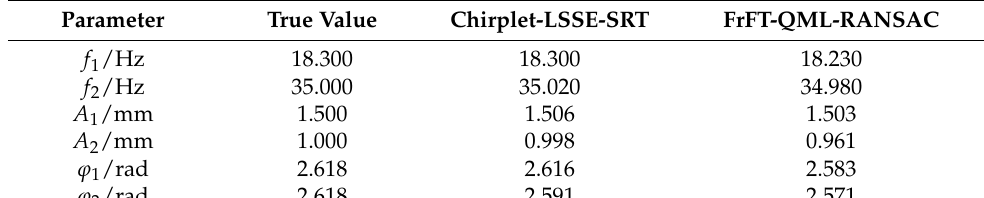
Figure 12. ICR estimation of the distributed imaging scene.